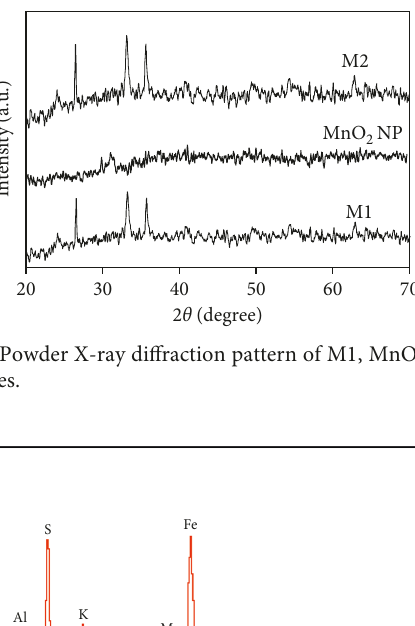
2 nanoparticles (M2).